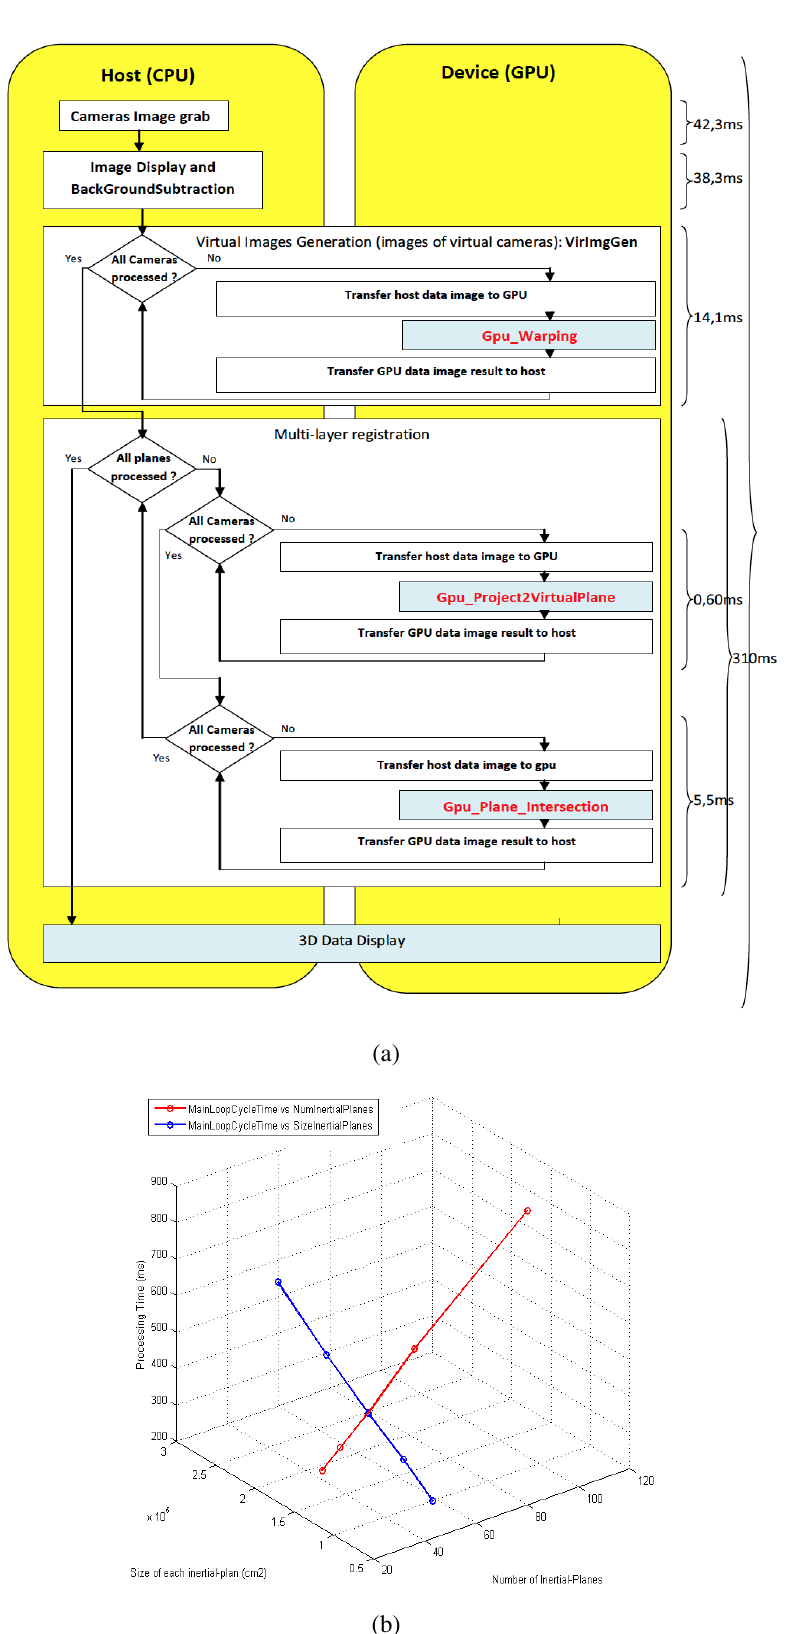
Figure 12. ( a ) Our 3D human movement analysis system is implemented using CUDA enabled GP-GPU enabling real-time performance; ( b ) Processing time with respect to number of inertial Euclidean planes and size ( cm 2 ) of each inertial